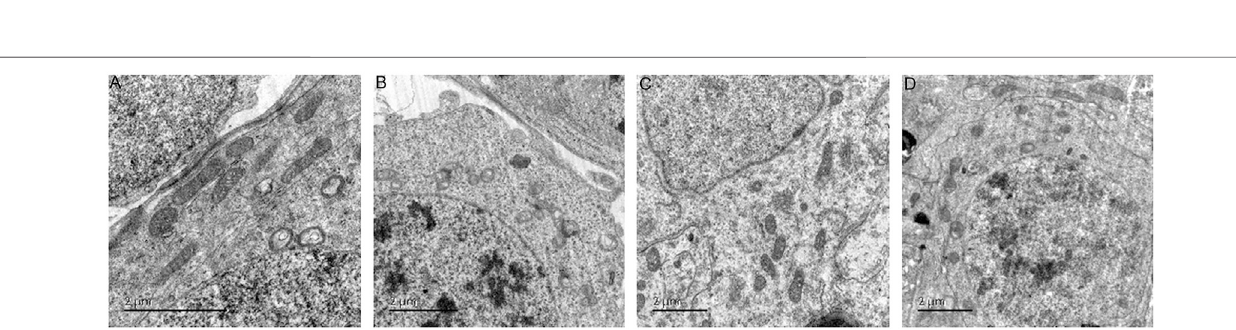
FIGURE 11 | The Apoptosis of rat spermatogenic cells [TUNEL × 400. (A) : normal group; (B) : model group; (C) : ZBDHD group; (D) : positive control group].